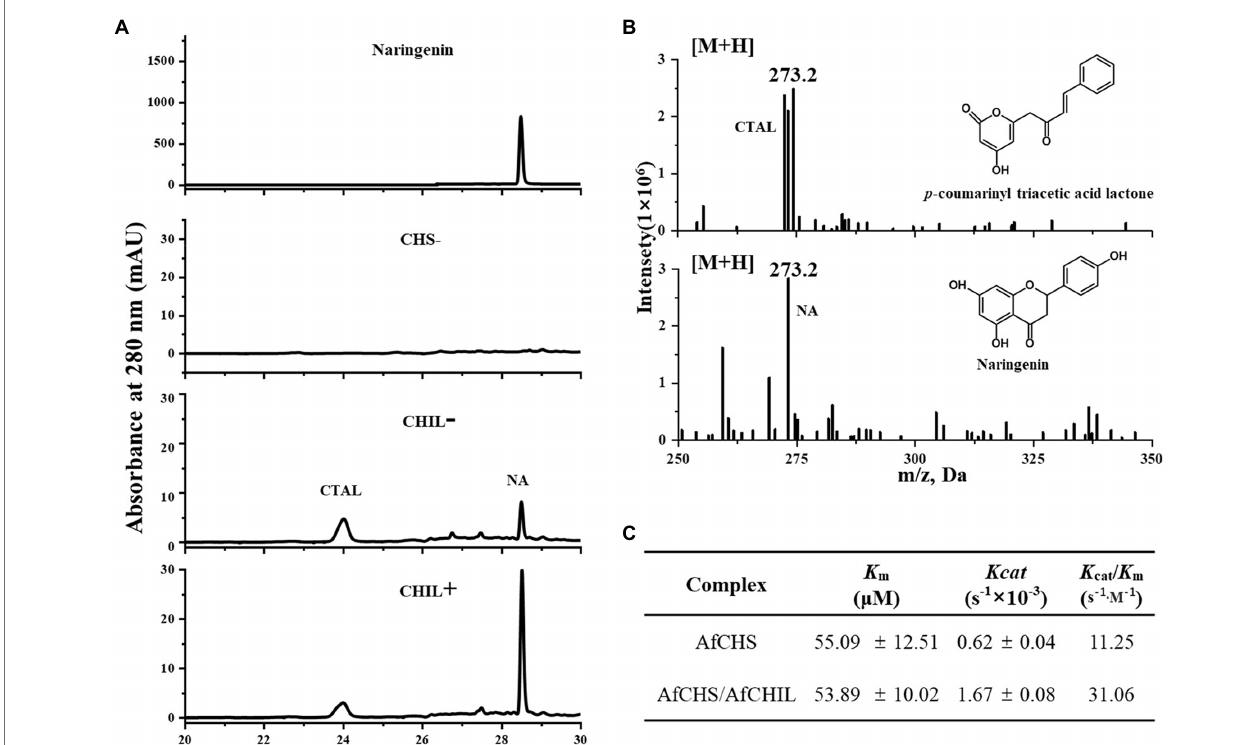
FIGURE 6 | Effect of AfCHIL on enzymatic properties of AfCHS. (A) HPLC chromatograms showing the effect of AfCHIL on the enzymatic activity of AfCHS in vitro : N.A., naringenin standard; empty control, pET15b empty (CHS − ); AfCHS (CHIL − ), and AfCHS/AfCHIL(CHIL+). (B) LC-MS analysis of CTAL and naringenin. (C) Kinetic parameters of AfCHS or AfCHIL/AfCHS1 complexes with p -coumaroyl-CoA and malonyl-CoA as substrates. For kinetic determination, malonyl-CoA at a fixed concentration of 200 μ M and p -coumaroyl-CoA at a series of concentrations (20–200 μ M), The K m and K cat values were calculated by nonlinear regression curves fitted to the Michaelis–Menten equation using GraphPad Prism